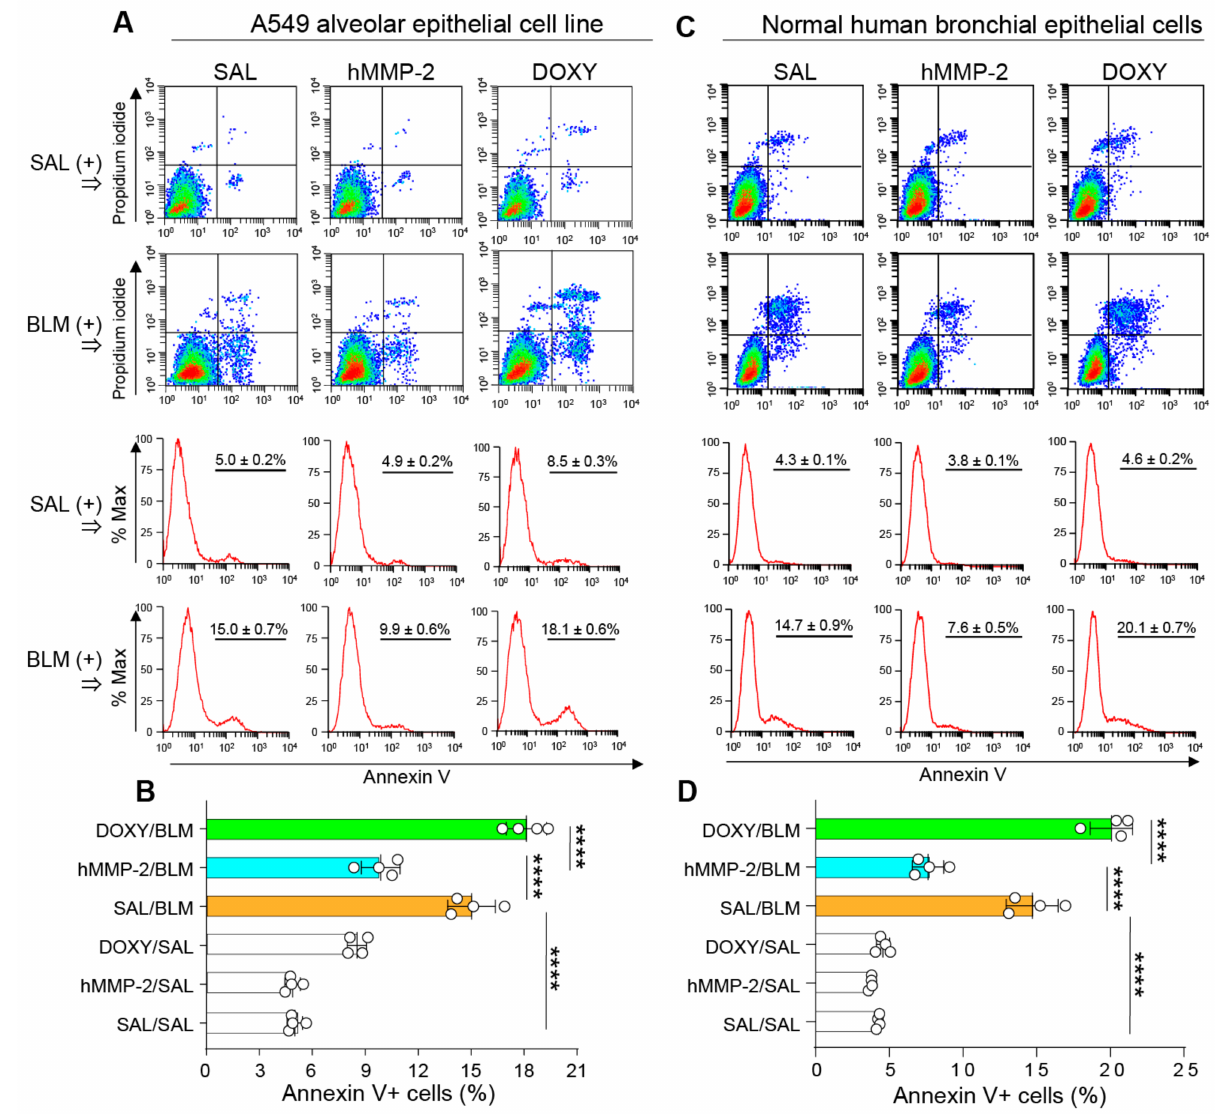
Figure 9. Active hMMP-2 inhibits apoptosis of lung epithelial cells. A549 cells ( A , B ) and normal human bronchial epithelial (NHBE) cells ( C , D ) were cultured and pretreated with active hMMP-2 (0.5 µ g/mL) or doxycycline (25 µ g/mL) before stimulating with BLM (50 mU/mL) to evaluate apop- tosis by flow cytometry. n = 4 in each treatment group. Data are the mean ± S.D. Statistical analysis by ANOVA with Newman-Keuls test. **** p < 0.0001; hMMP-2, human matrix metalloproteinase-2; SAL, saline; BLM, bleomycin. DOXY,